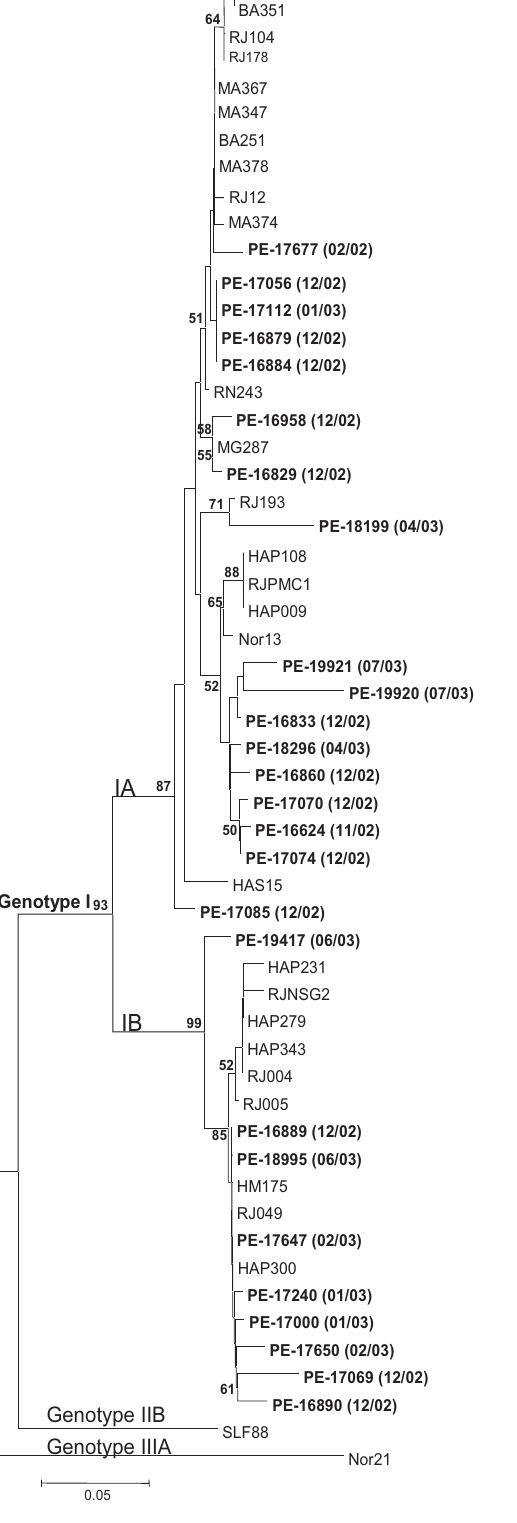
Figure 1. Phylogenetic tree analysis of the VP1-2A region in hepatitis A virus (HAV) isolates from Pernam- buco (PE). A 218-bp segment of the HAV VP1/2A junction was analyzed using the two-parameter model of Kimura. The numbers on the branches show boot- strap percentages obtained after 1000 replicates of bootstrapping sampling. The length of bars shows the distances. The numbers in parentheses show the month and year of strain isolation. Genotype and sub- genotype are indicated for each branch.